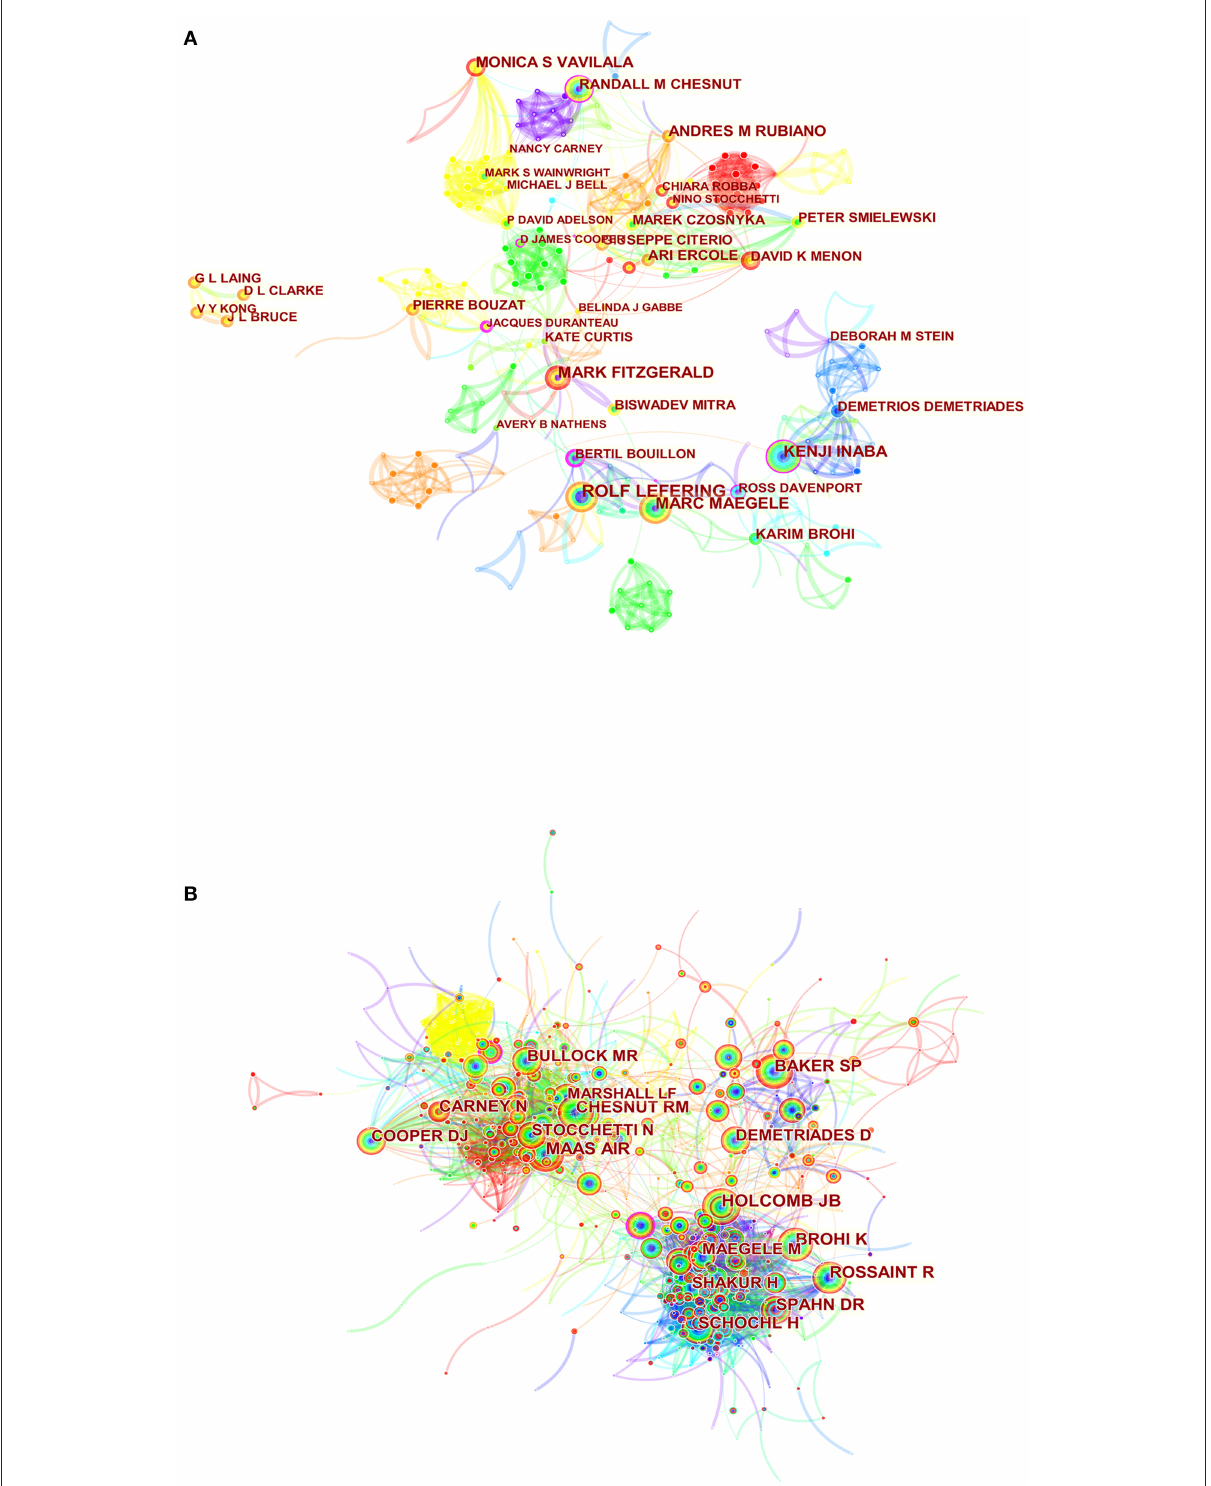
FIGURE4 Visual analysis of authors (A) and co-cited authors (B) . The node size represents the number of studies published by the author, with larger nodes representing a higher number of publications. The closer the collaboration between two writers, the shorter the distance between two nodes. The purple nodes represent early published articles, while the red nodes represent recently published